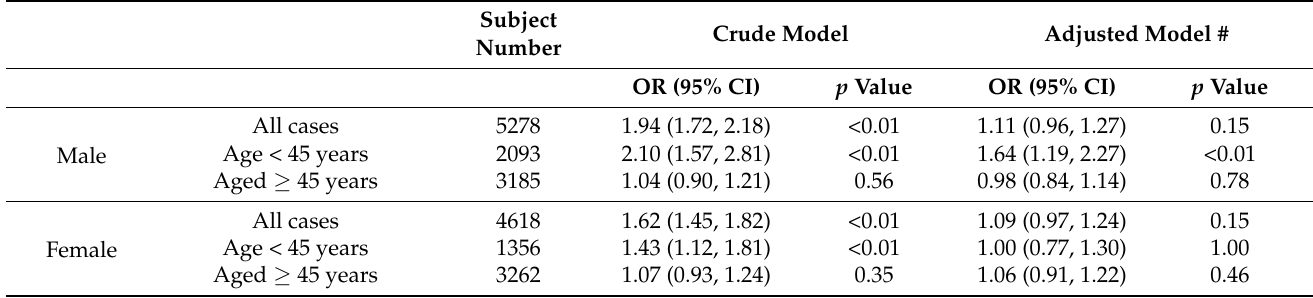
Table 5. Stratified analyses by age and gender on the association of all cancer risk with HEV exposure.